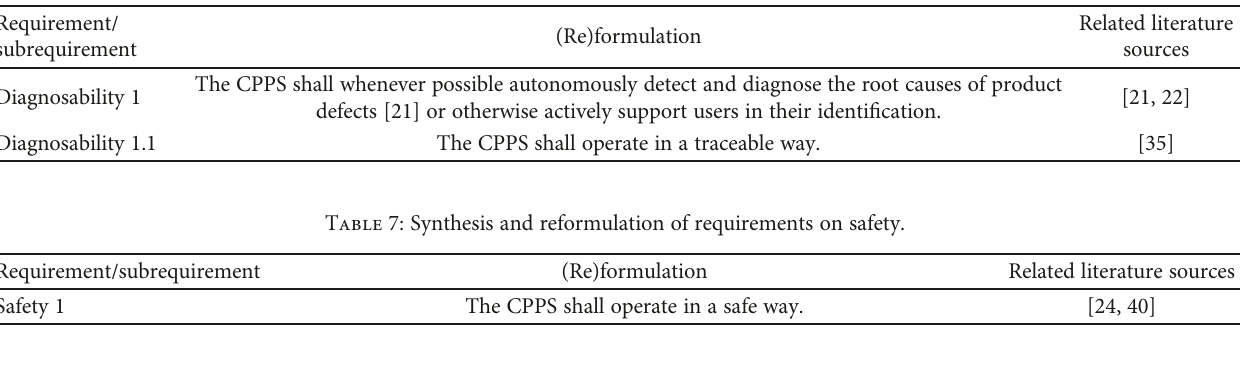
Table 8: Synthesis and reformulation of requirements on